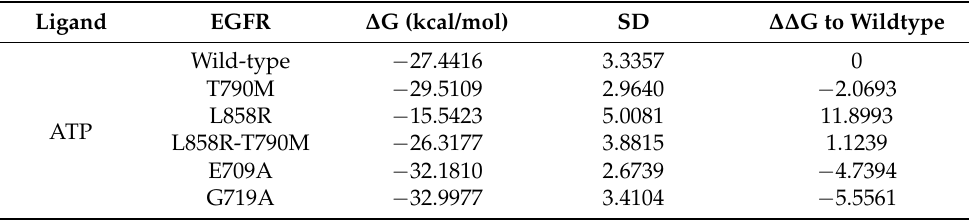
Table 1. Binding energy of ATP analog to the wild-type and known mutated EGFR. Ligand EGFR Δ G (kcal/mol) SD ΔΔ G to Wildtype Wild-type − 27.4416 ATP